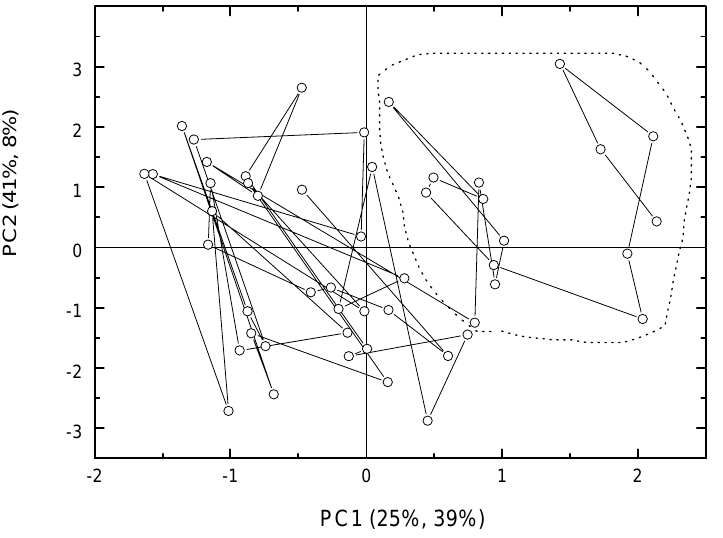
Figure 9. PLS-1 score plot of all samples in test mixtures of key odorants containing ammonium at pH 8. Samples (15 samples) with high concentrations (5 × 10 -4 - 10 -3 M) of n-butyrate are surrounded by dashed line. Full cross validation was used and six electrodes were sufficient.